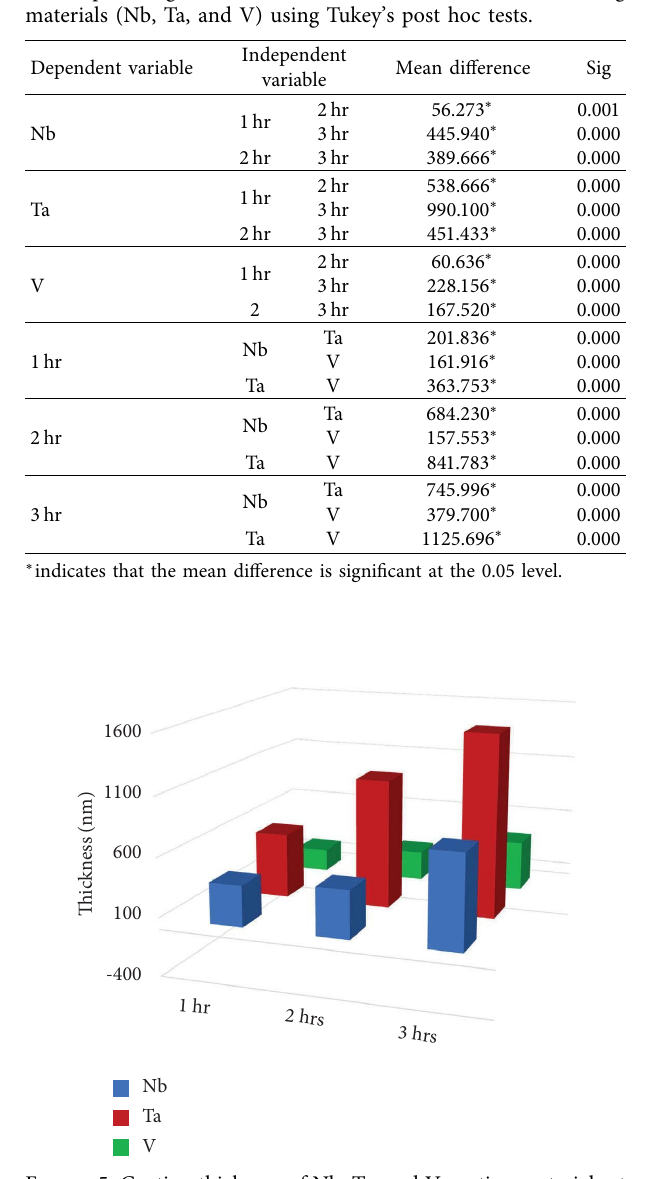
Figure 5: Coating thickness of Nb, Ta, and V coating materials at diferent sputtering